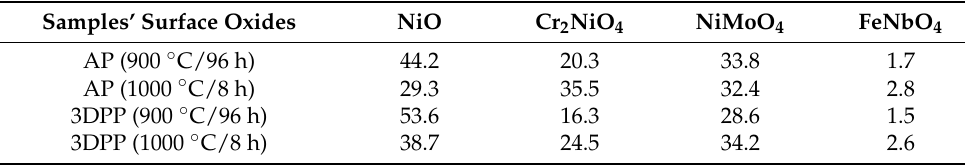
Table 3. Oxides formed in the corrosive layers and their ratios (wt.%).